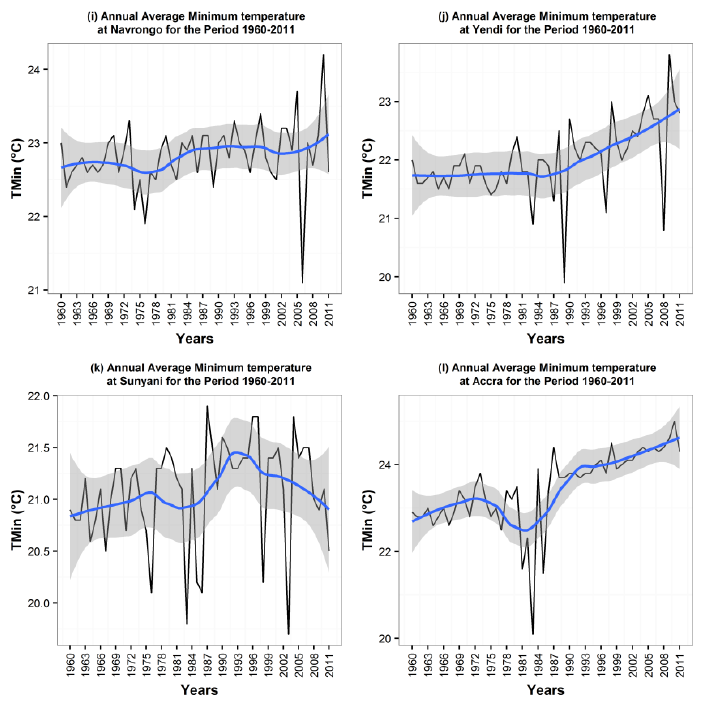
Figure 6. Minimum temperature time series of four selected stations in Ghana. The blue line or regression line represents a smoother. The grey band is the display of the confidence interval (95% confidence interval) around the smoother.